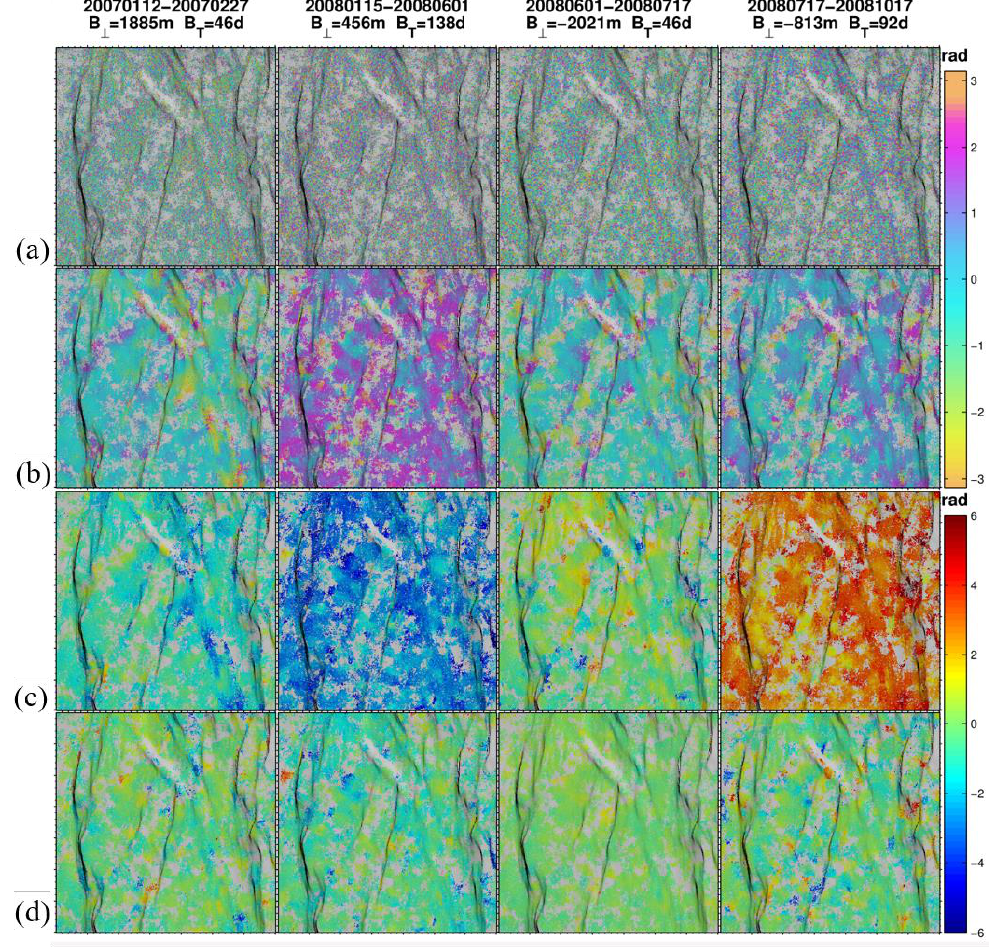
Figure 6. Four examples of interval phase estimation and systematic error correction. Four consecutive interferograms are displayed. ( a ) The first row represents the original single-looked interferograms; ( b ) The second row represents the consecutive interferograms after interval phase estimation in wrapped form. ( c ) The third row represents the consecutive interferograms after interval phase estimation in unwrapped form. ( d ) The fourth row represents the consecutive interferograms in unwrapped form after interval phase estimation and systematic error correction.